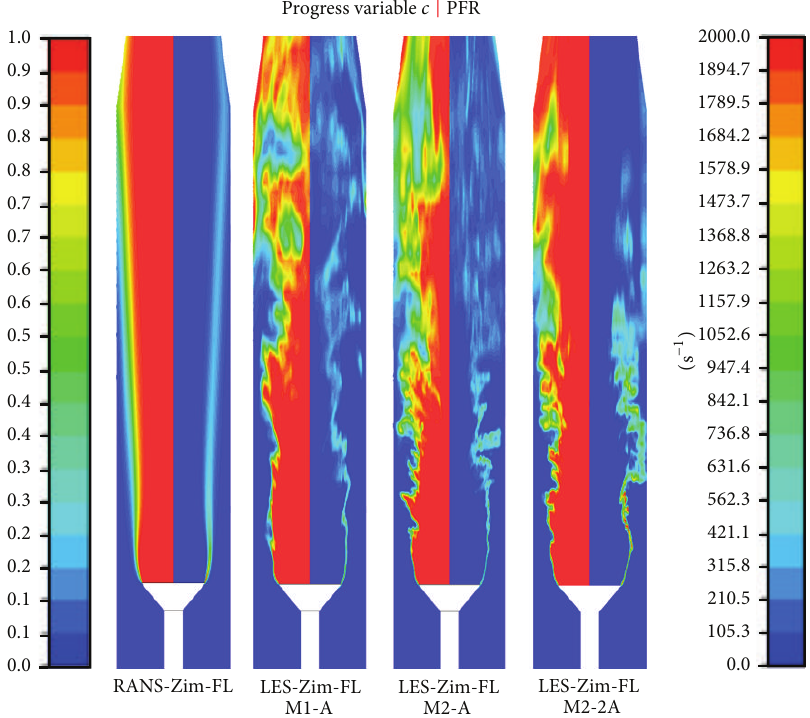
Figure 7: Instantaneous progress variable and PFR contours (longitudinal view).